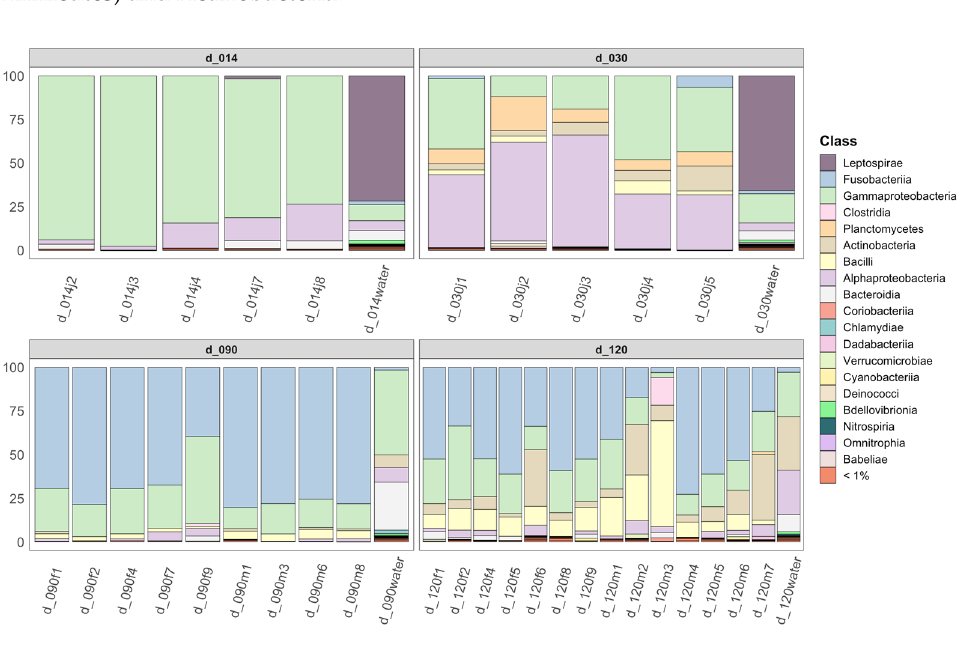
Figure 2. Principal coordinates analyses based on the unweighted ( A ) and weighted ( B ) UniFrac dis- tances, illustrating the bacterial compositions from water and fish samples according to sampling date.